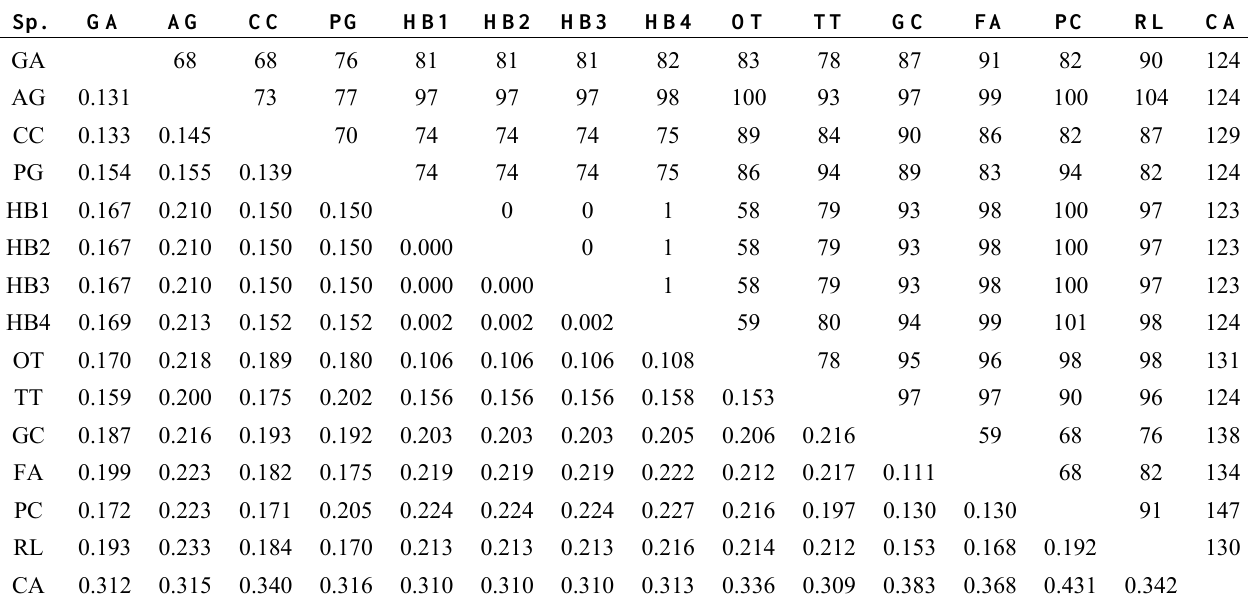
Table 1. Distance matrix of pair-wise sequence